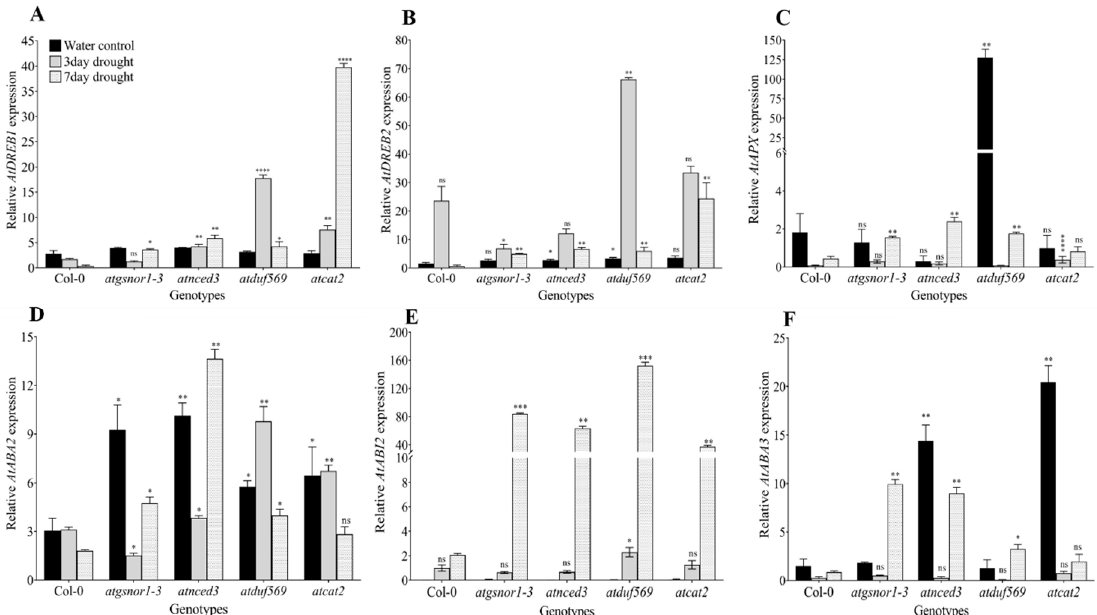
Figure 6. Expression analysis of genes related to abscisic acid synthesis and drought signaling in Arabidopsis plants under drought stress. Gene expression levels of ( A ) AtDREB1 , ( B ) AtDREB2 , ( C ) AtAPX , ( D ) AtABA2 , ( E ) AtABI2 , and ( F ) AtABA3 in various Arabidopsis genotypes. Data represent means of values obtained from experiments performed in triplicate. Error bars represent standard deviation. Means were analyzed for significant differences using Student’s t -test. Asterisks indicate significant whereas “ns” indicate non-significant differences at 5% level of significance (**** p < 0.0001, *** p < 0.001, ** p < 0.01, * p < 0.05).